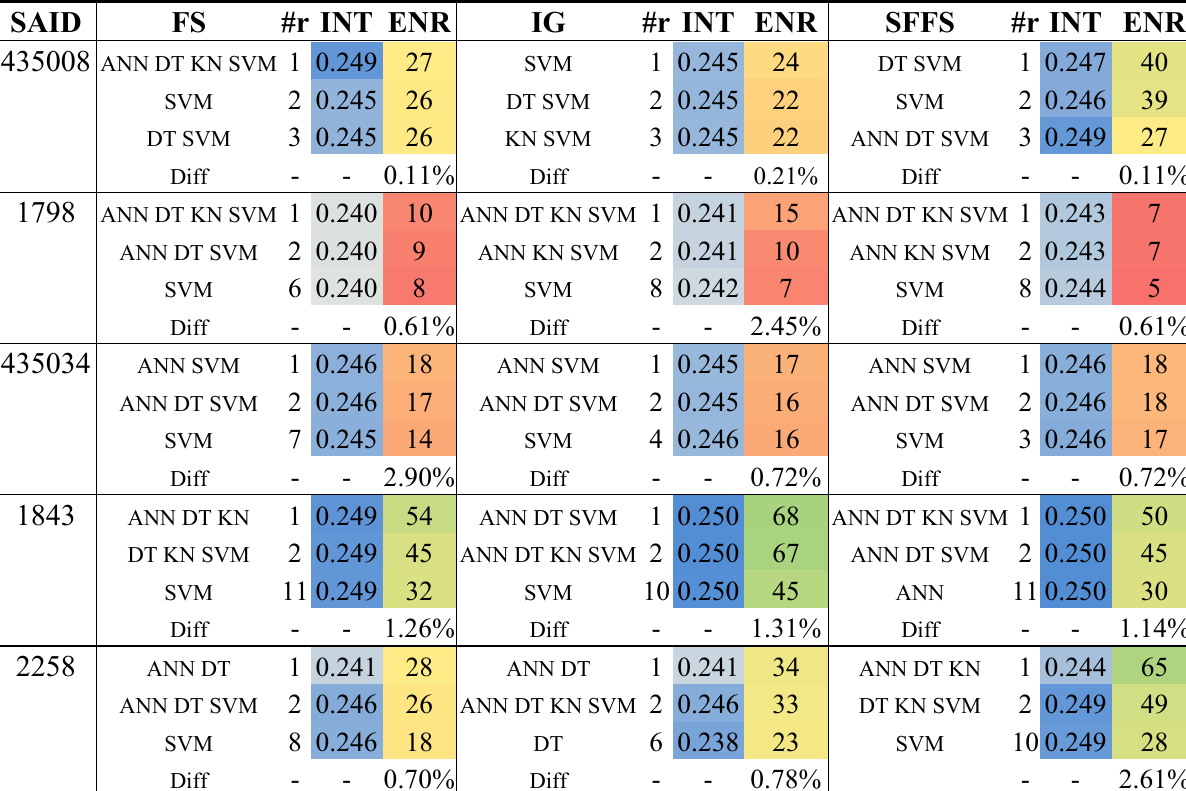
Table 3. The top two ranking (#r) consensus QSAR models are presented for each PubChem data set (SAID) and descriptor selection techniques: F-Score (FS), Information gain (IG), and sequential feature forward selection (SFFS). Every model is evaluated by the integral of the TNR-TPR curve with a TPR rate of 0.00 to 0.25 (INT). The ranking is ordered by Enrichment (ENR). The best single predictor is shown for comparison. The ENR difference of the best consensus predictor compared to the best single predictor normalized by the inactives-to-actives ratio is given (Diff).